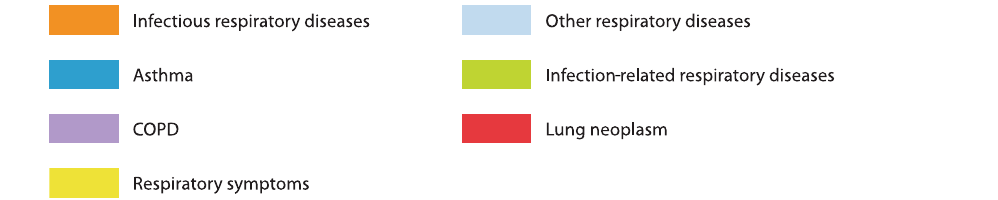
Fig. 2 Proportional distribution of respiratory conditions identi fi ed by participants as most clinically